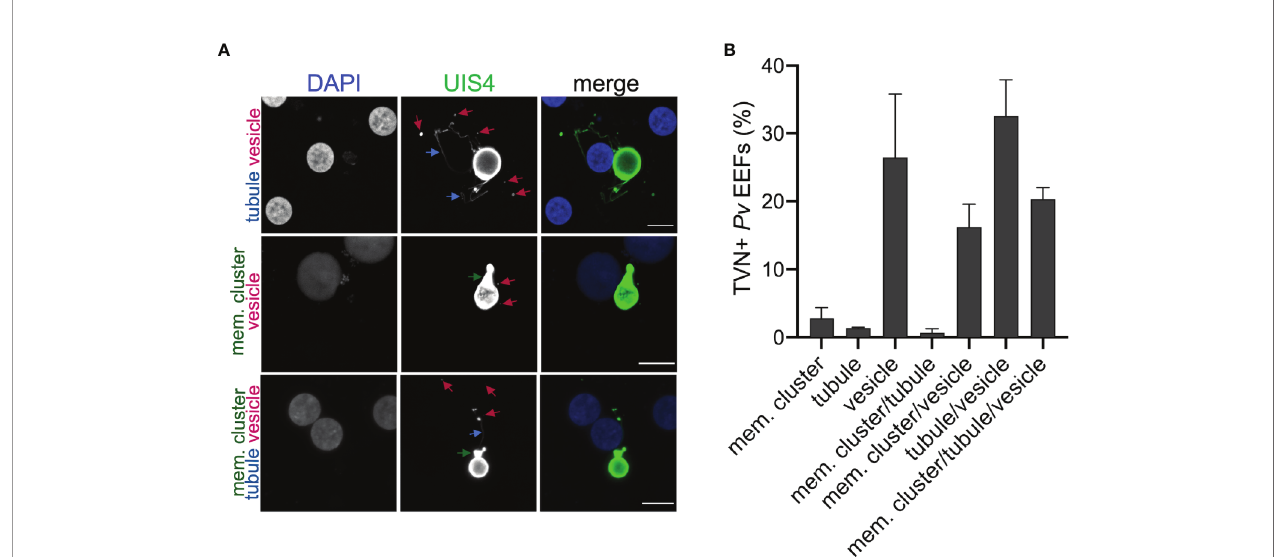
FIGURE 2 | P. vivax TVN phenotypes. (A) Representative confocal images of P. vivax EEFs with TVN features in PHH at 8 dpi. Cells stained with DAPI (blue) and anti- Pv UIS4 (green). TVN features observed indicated as extended membrane cluster (mem. cluster, green arrow), tubule (blue arrow), and vesicle (magenta arrow). Scale bar is 10 µm. (B) Characterization of EEFs displaying one or more TVN features on 8 dpi. Data reported as mean ± SEM (3 independent wells assessed with >200 parasites, n=2 biological replicates).